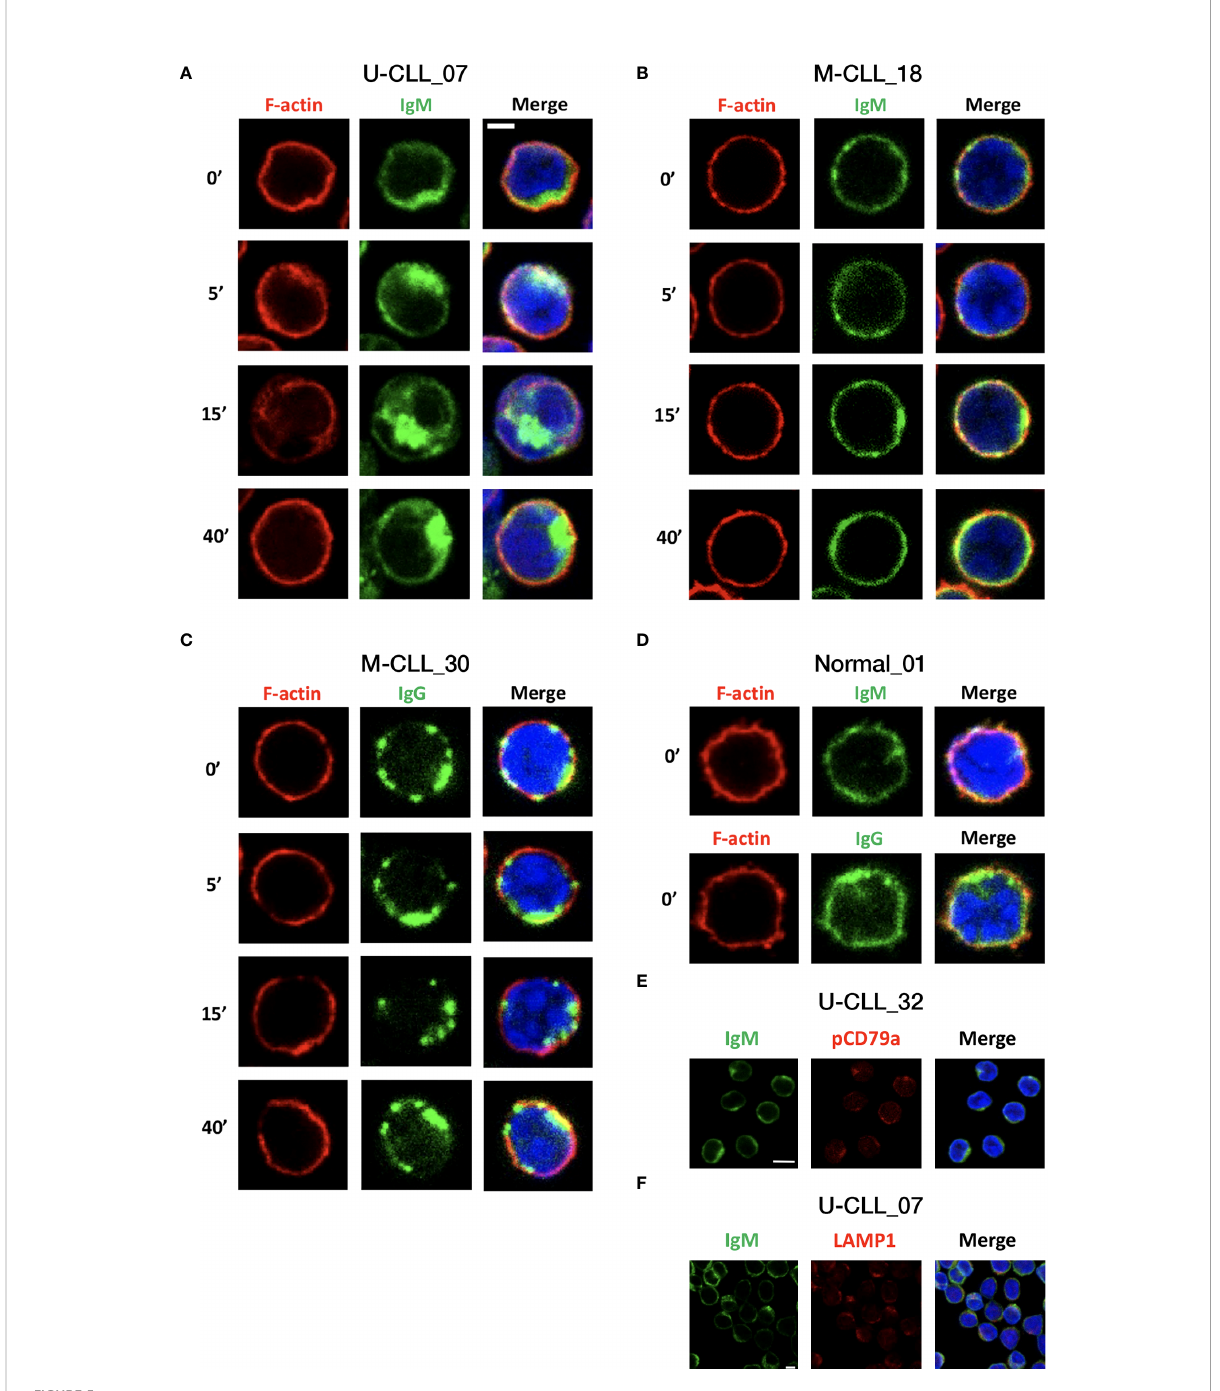
FIGURE 5 IgM, IgG, and F-actin distribution and localization before and after activation. CLL cells were seeded on poly-L-lysine – coated glass and then left either inactivated or activated with F(ab ′ )2 Fragment anti-IgM or F(ab ′ )2 Fragment anti-IgG for 5, 15, and 40 min. The cells were fi xed and permeabilized, followed by staining. The images presented are confocal slices through the center of the cell. (A) Representative IgM U-CLL case. (B) Representative IgM M-CLL case. (C) Representative IgG M-CLL case. (D) Representative case of IgM and IgG staining in normal B cells. Scale bar, 2 m m. (E) Unstimulated CLL cells were stained for IgM and pCD79a. Representative images of patient with U-CLL are shown. Scale bar, 5 m m (n = 3). (F) Unstimulated CLL cells were stained for IgM and LAMP1. Representative images of patient with U-CLL are shown. Scale bar, 2.5 m m (n =